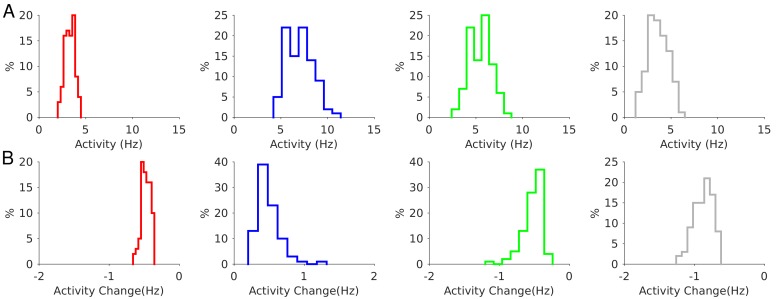
Model 1 with JEE>JEE*.Robustness to a change of ±10% in the interaction parameters. (A) Distribution of the population activities. (B) Distribution of the activity changes upon stimulation for Γopto=0.07mW.mm-2. Color code as in Figure 5. Rates are averaged over 10s.